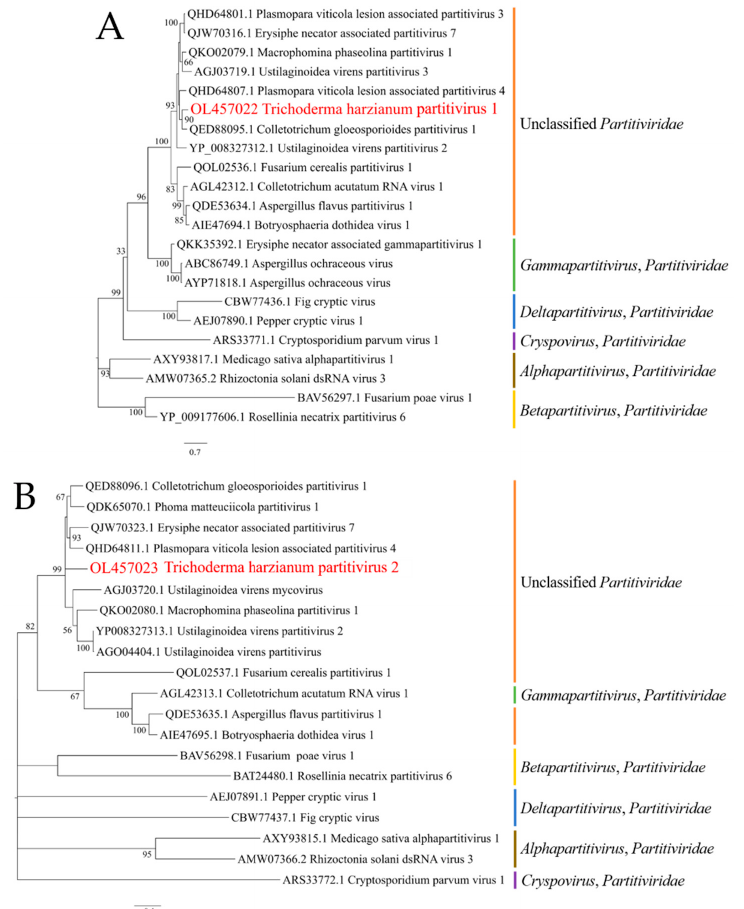
Figure 2. Maximum likelihood (ML) phylogenetic trees of viral RNA-dependent RNA polymerases ( A ) and hypothetical proteins with similarities to the hypothetical protein ( B ) of the novel dsRNA virus of T. harzianum strain T673. Both alignments suggest a close relationship with the Partitiviridae family (see text).